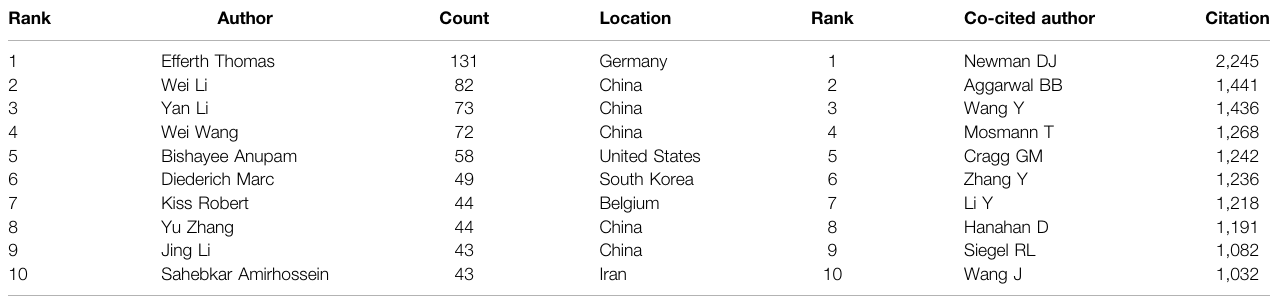
TABLE 5 | The top 10 productive authors and co-cited authors related to natural products in cancer research.